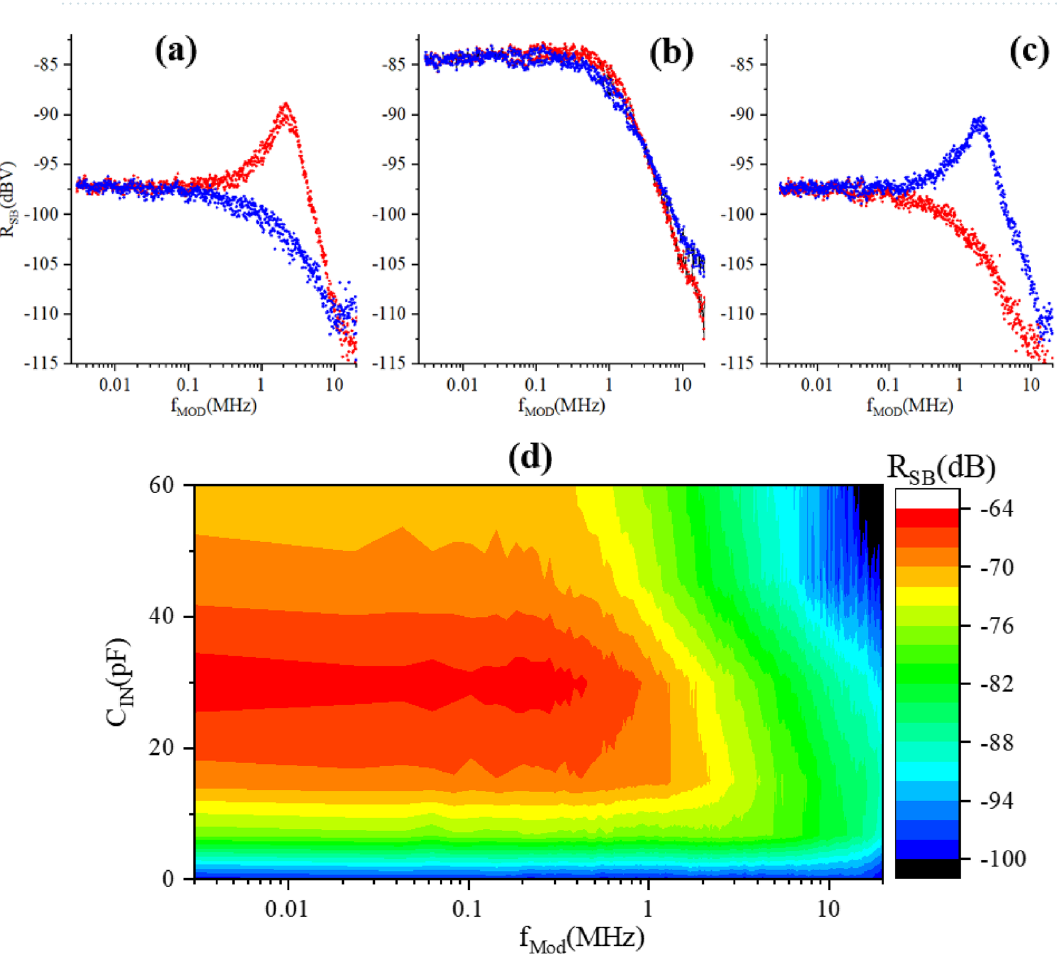
Figure 8. Error-corrected magnitude of reflection (lower SB -blue dots, upper SB - red dots) vs carrier frequency for MN connected to SEBA with L C IN = 30 pF. The signal is measured at the input of the UHFLIA in Fig. 2a. Sinusoidal signal with RMS value of 3.5 mV is applied to the gate of SEBA along with a constant V g 0 = 0.879 V, positioning the response of the SEBA at the peak in SB signal in Fig. 7c. The three selected operation frequencies are shown by blue (400.6 MHz), green (402.6 MHz) and red (404.6 MHz) dots. T=3.6K.